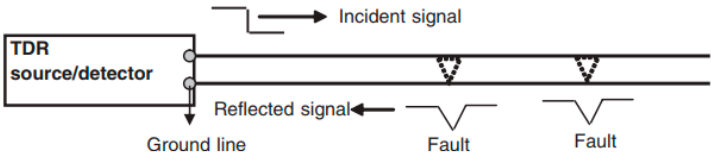
Figure 16. Schematic illustration of TDR defect detection method [115].